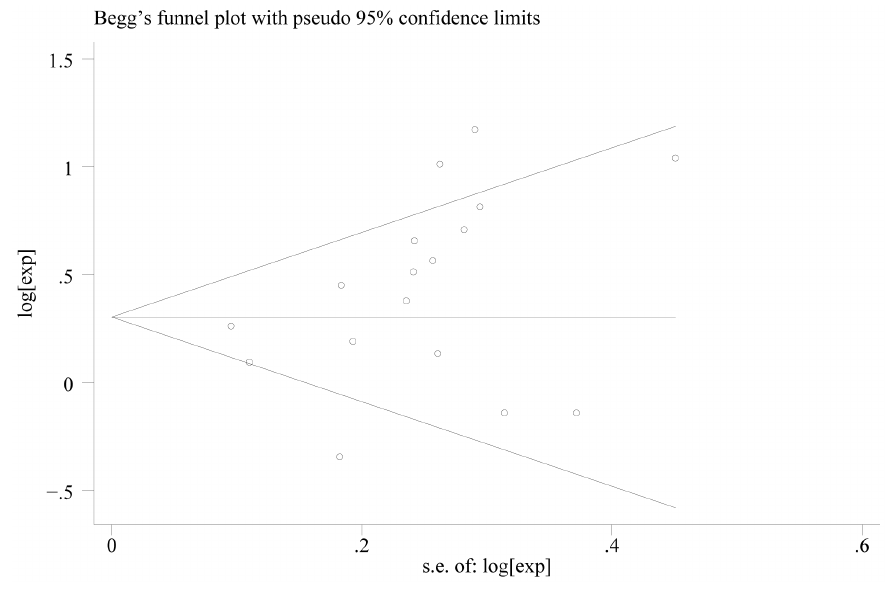
Figure 3. Begg’s test result of OS.